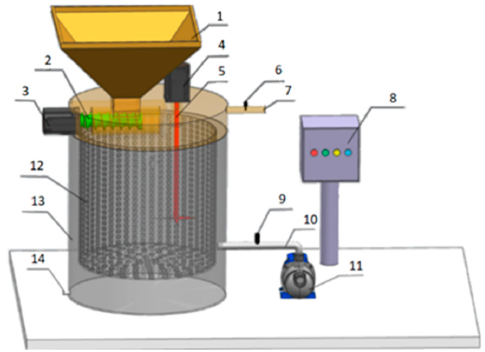
Figure 1. Schematic diagram of the solid-fertilizer-dissolving and -applying device: (1) hopper; (2) screw rod; (3) stepping motor; (4) direct-current motor; (5) mixer; (6) EC sensor; (7) fertilizer solution outlet pipe; (8) control cabinet; (9) flow sensor; (10) water inlet pipe; (11) direct-current pump; (12) filter; (13) mixing barrel; (14) sewage outlet pipe.